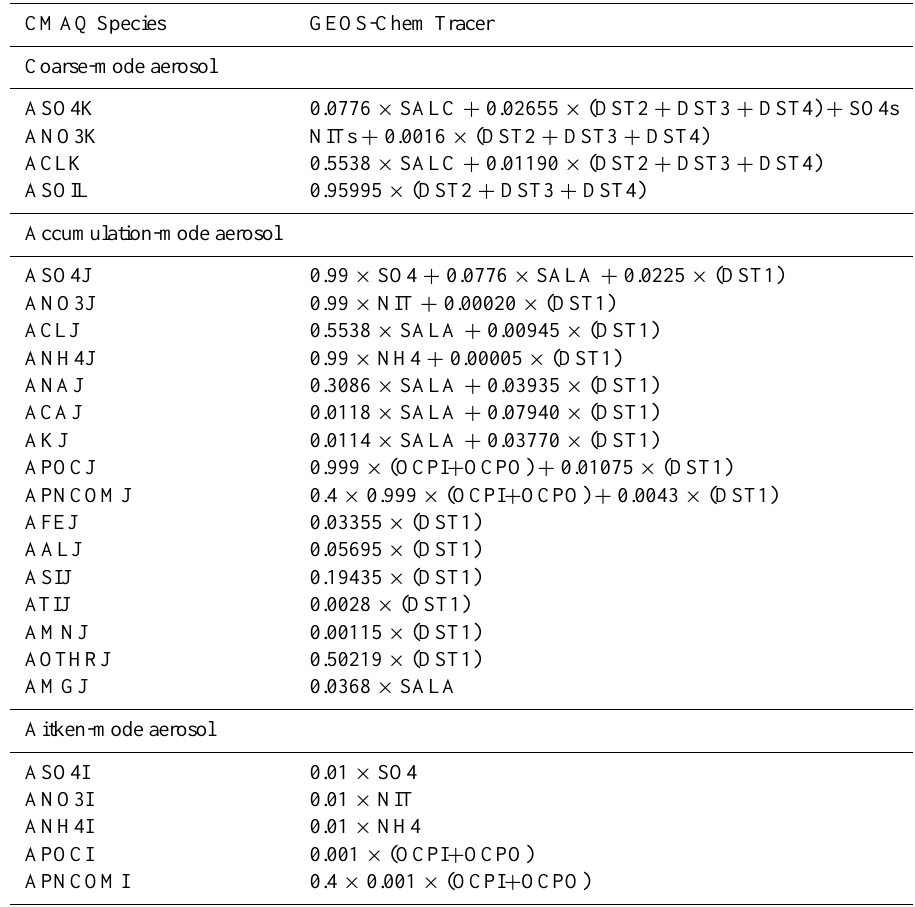
Table 3. GEOS-Chem to CMAQ boundary condition mapping for dust and inorganic aerosol species. SALA and SALC represent accumu- lation and coarse sea salt in GEOS-Chem. SO4s and NITs are sulfate and nitrate formed on sea-salt aerosol. OCPI and OCPO are primary organic carbon in